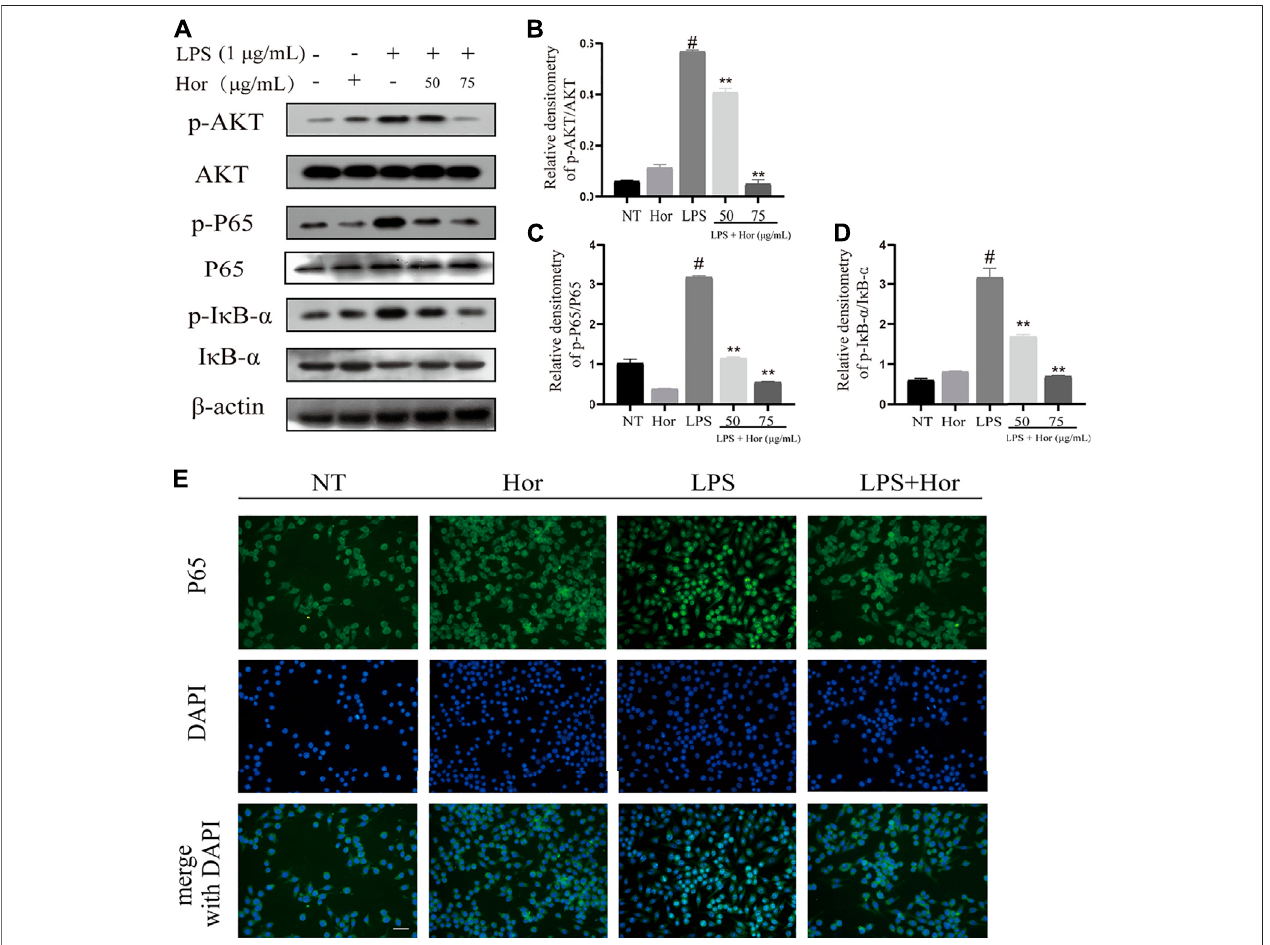
FIGURE 6 | Hordenine inhibits phosphorylation of the AKT and NF- κ B signaling pathways in LPS-induced RAW264.7 cells. Cells were pre-treated with hordenine for 1 h, followed by LPS treatment for 1 h, and cell proteins were collected. (A) Protein levels of p-AKT, p-p65, p-I κ B, AKT, p65, and I κ B in RAW264.7 cells. (B – D) Quanti fi cationofp-AKT, p-p65,and p-I κ BbywesternblottinginRAW264.7cells. (E) Translocationofp65proteinintothenucleusofRAW264.7cells.Greenrepresents p65 protein and blue represents the nucleus. Green fl uorescence in the location of the nucleus was greater than that in the cytoplasm, indicating that p65 was translocatedintothenucleus(magni fi cation, × 400;scalebar (cid:1) 100 μ m).Results areshownasmeans ± SD( n (cid:1) 3).# p < 0.01vs. notreatment (NT) group; pp p < 0.01vs. LPS group. DAPI, 4 ′ ,6-diamidino-2-phenylindole; Hor: hordenine; LPS: lipopolysaccharide; p-AKT: phosphorylated protein kinase B; p-I κ B: phosphorylated inhibitor of nuclear factor- κβ ; p-p65: phosphorylated p65.